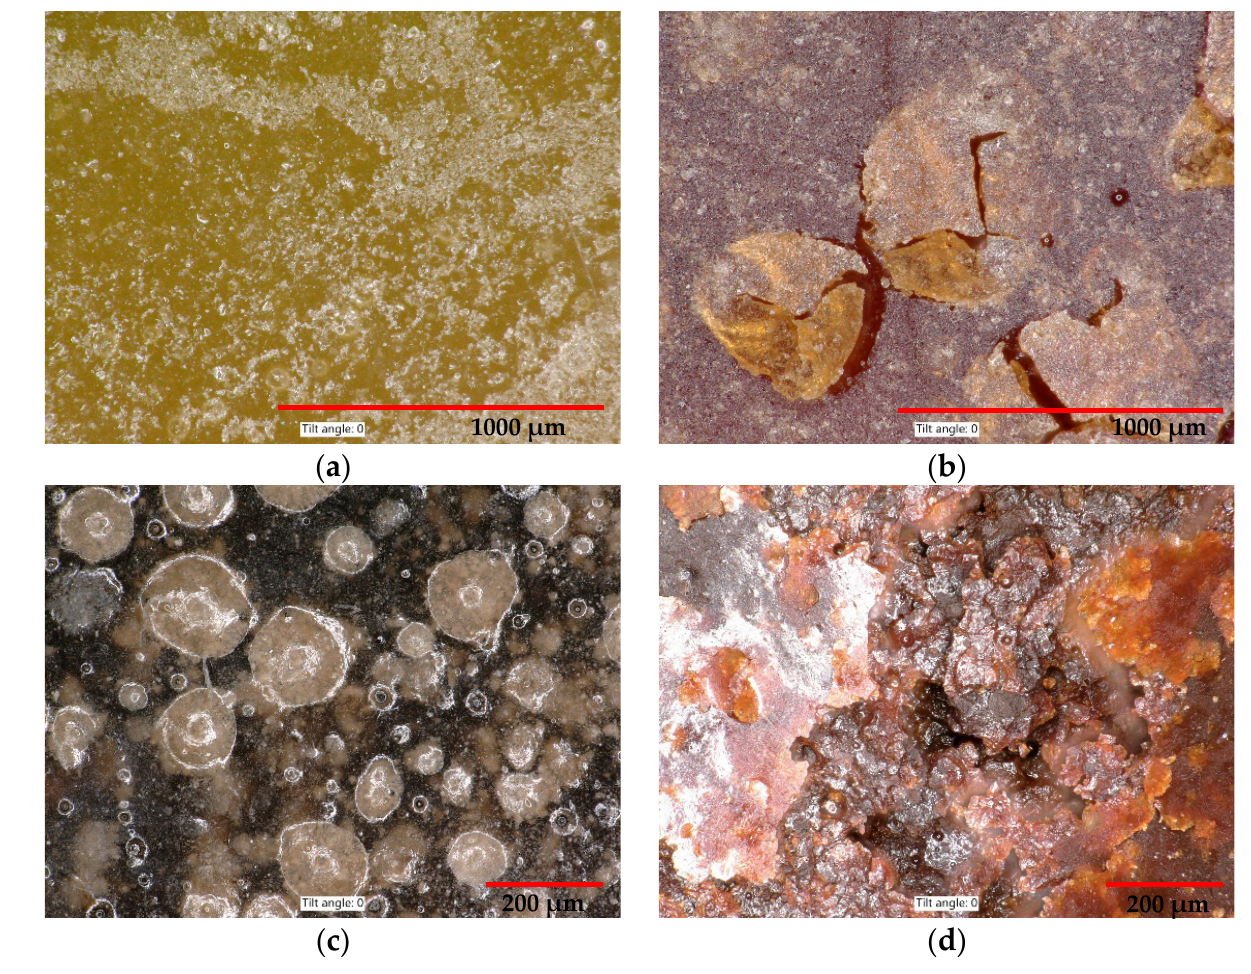
Figure 17. Samples of the epoxy composite with REF and NS filler following exposure to chemical stress: ( a ) REF in H 2 SO 4 , magn. 200×; ( b ) REF in CH 3 COOH, magn. 200×; ( c ) NS in H 2 SO 4 , magn. 100× ( d ) NS in CH 3 COOH, magn. 100×.